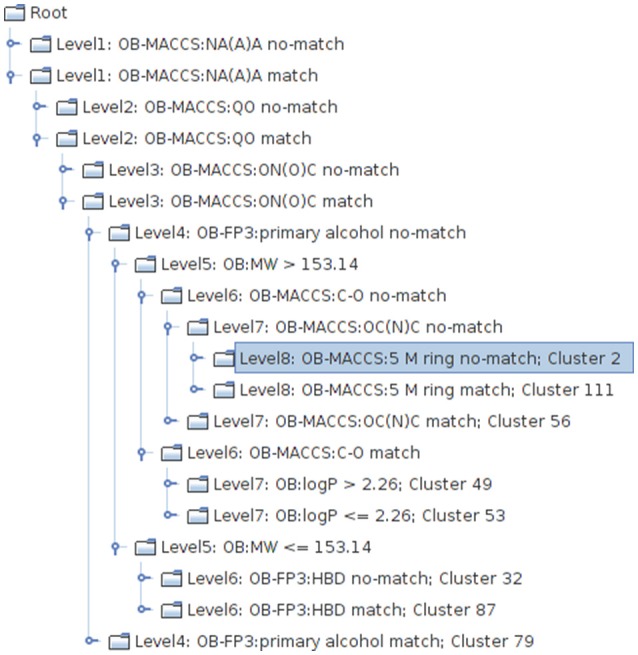
Excerpt from the PCT clustering result, visualized with the tree view implemented in the CheS-Mapper tool (Gütlein et al., 2012). One structural feature is used at each level of the tree to divide chemicals into sub-groups with high toxicological similarity.